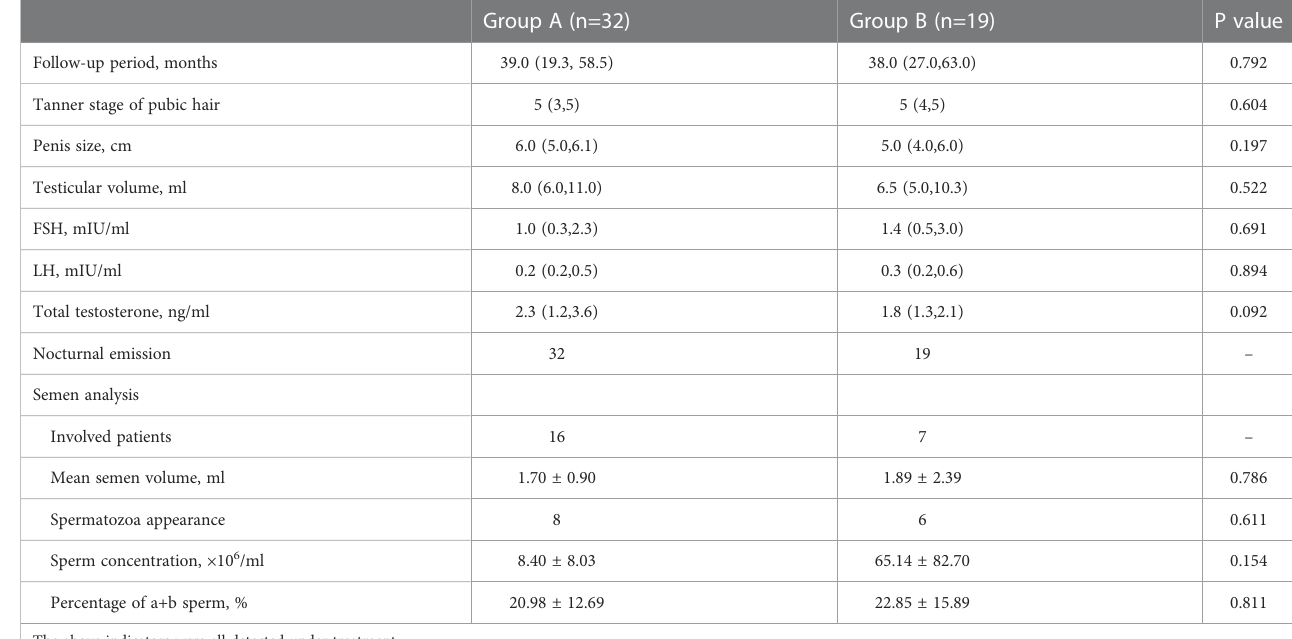
TABLE 3 The effects of hormonal therapy in patients in the two